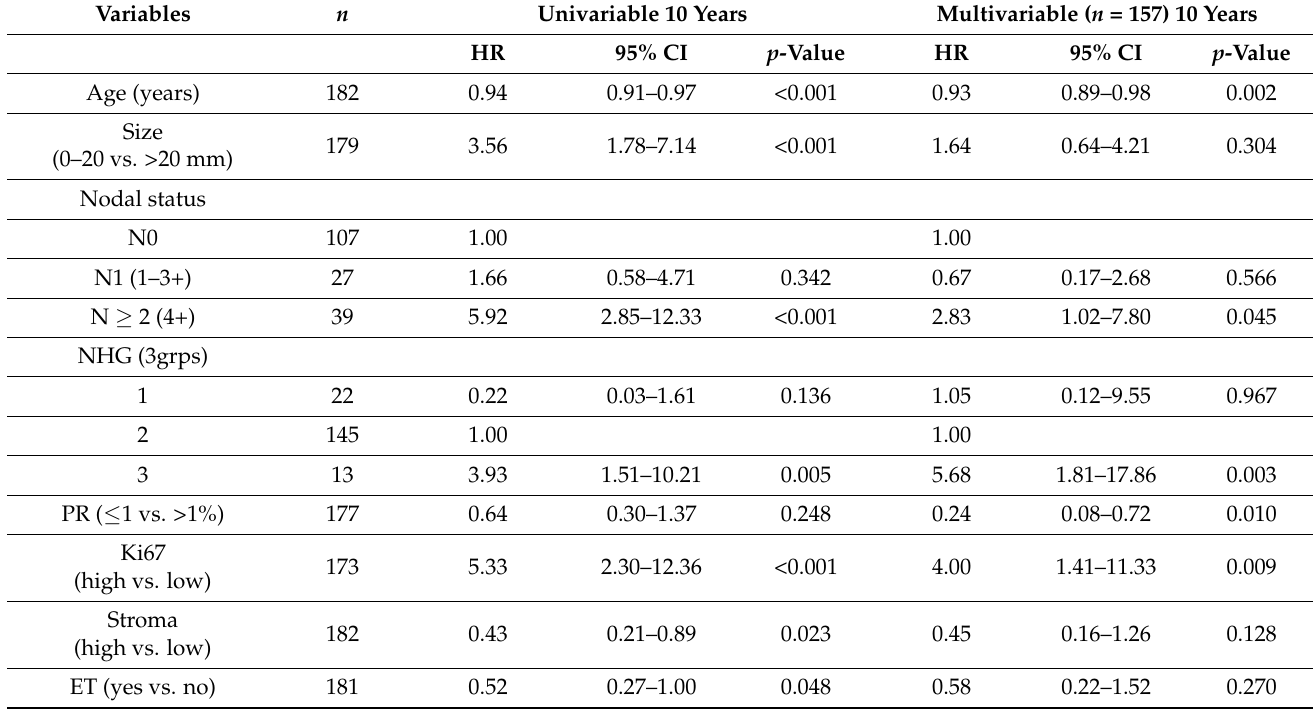
Figure 3. Risk of breast cancer death in lobular breast cancer by intratumoral stromal content; 10- and 25-year follow-up. Abbreviations: BC—breast cancer; CI—confidence interval; HR—hazard ra- tio. Table 2. Patient and tumor characteristics associated with breast cancer mortality after 10-year follow-up in univariable and multivariable analyses.